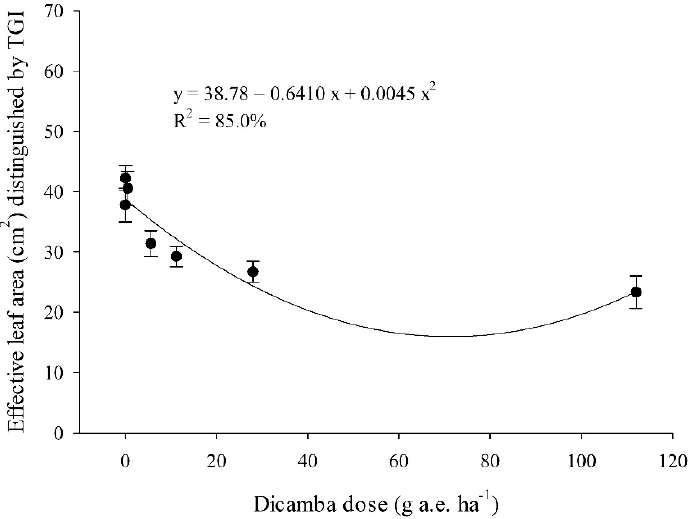
Figure 3. Effective soybean leaf area (cm 2 ) shown by the triangular greenness index (TGI) and estimated by the Quant ® software at 5 days after the application of the dicamba doses (0, 0.056, 0.56, 5.6, 11.2, 28, 112 g.e. ha − 1 ). Error lines in each point denote standard deviation. The lowest dicamba doses of 0.056 and 0.56 g a.e. ha − 1 presented slightly superior TGI canopy color distinction compared to the control treatment (0 g a.e. ha − 1 of dicamba).